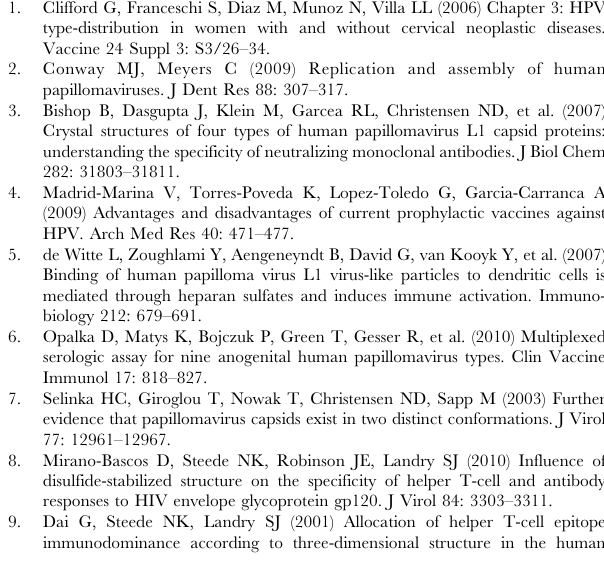
(TIF) Figure S4 Anti-HPV16 L1 IgG titers and neutralization activities of mice sera following immunizations with schHPV16 and scHPV16 VLP. Mice were immunized subcutaneously three times with 8 ng of schHPV16 VLP or scHPV16 VLP without adjuvant. Ten days after the last immunization, the sera were obtained and analyzed as described in the Materials and Methods to determine the anti-HPV16 L1 IgG titers and neutralization activities. The horizontal bars are the median values (PBS, n= 6; schHPV16 VLP, n= 8; scHPV16 VLP, n =8). (TIF) Table S1 Determinations of LPS levels in Mock and HPV16 VLPs. Mock samples were prepared form the cell lysate of parent cell of HPV16 L1-producing S. cerevisiae . The concentrations of hHPV16 VLP and cHPV16 VLP were determined by SDS-PAGE and Western blotting prior to the assay. The LPS level of each sample was determined using the limulus amoebocyte lysate (LAL) based colorimetric system (ToxinSensor TM , GenScript, USA) according to the manufacture’s